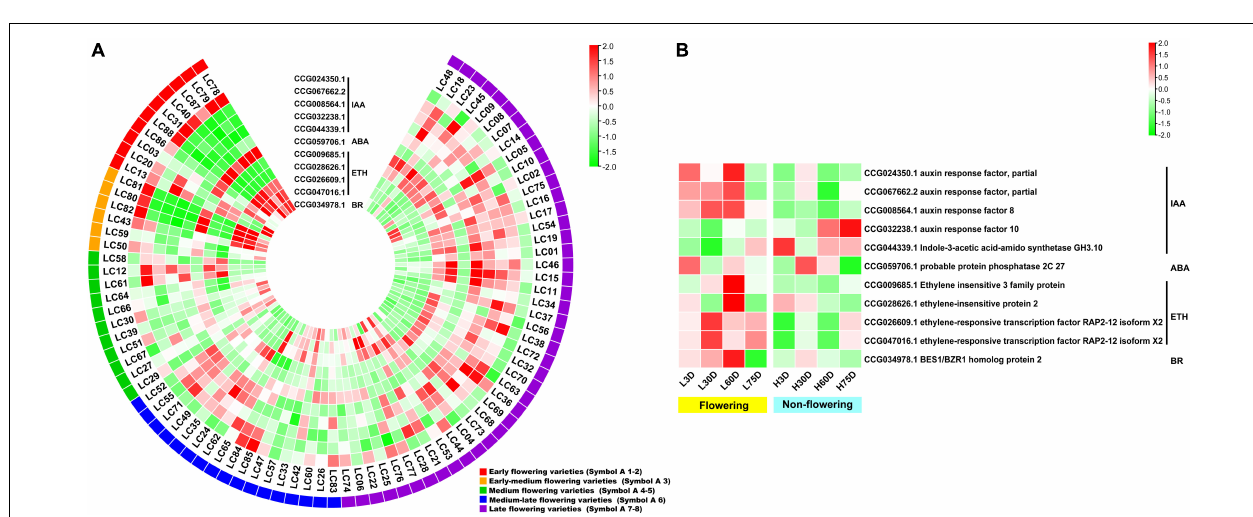
FIGURE 4 | Heat map diagram of the expression of hormone biosynthesis-related CAGs. (A) Heat map of the expression levels of the hormone synthesis-related CAGs in the 87 litchi accessions. (B) Heat map diagram of the expression levels of flowering-related CAGs under low and high temperature conditions. L3D, L30D, L60D, and L75D indicate 3, 30, 60, and 75 days of the low-temperature treatment, respectively. H3D, H30D, H60D, and H75D indicate 3, 30, 60, and 75 days of the high-temperature treatment, respectively. FPKM values were normalized to Z -score.